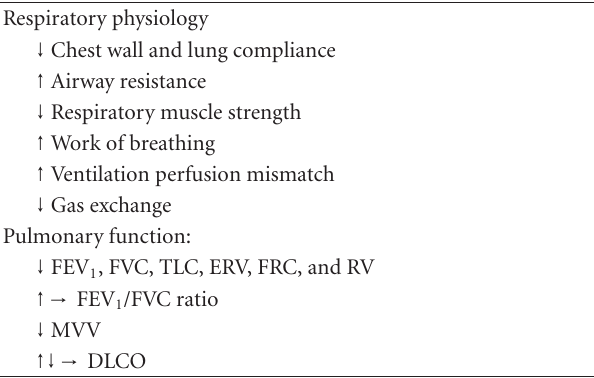
Table 1: Respiratory complications of